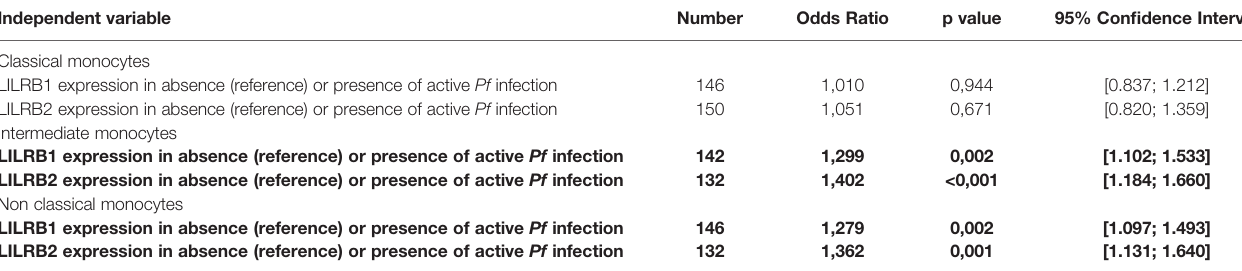
TABLE 4 | Higher expression of LILRB1 and LILRB2 on intermediate and non-classical monocytes at 18 and 24 months during active malaria. Independent